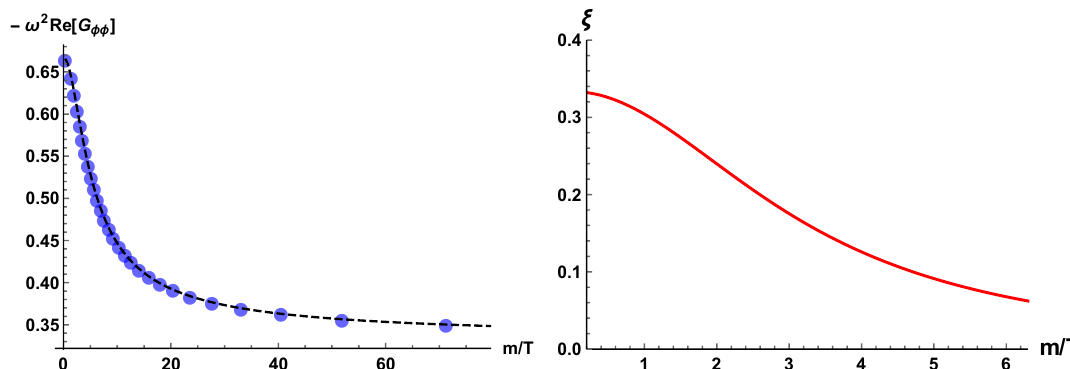
Figure 17 . Data for the potential V ( X ) = X 3 and zero chemical potential. Left: check of the correlator structure (B.2). The blue dots are numerical data and the dashed line is the analytic result for (cid:31) (cid:0) 1 . Right: the (cid:24) parameter extracted from the imaginary part of the (cid:30) PP